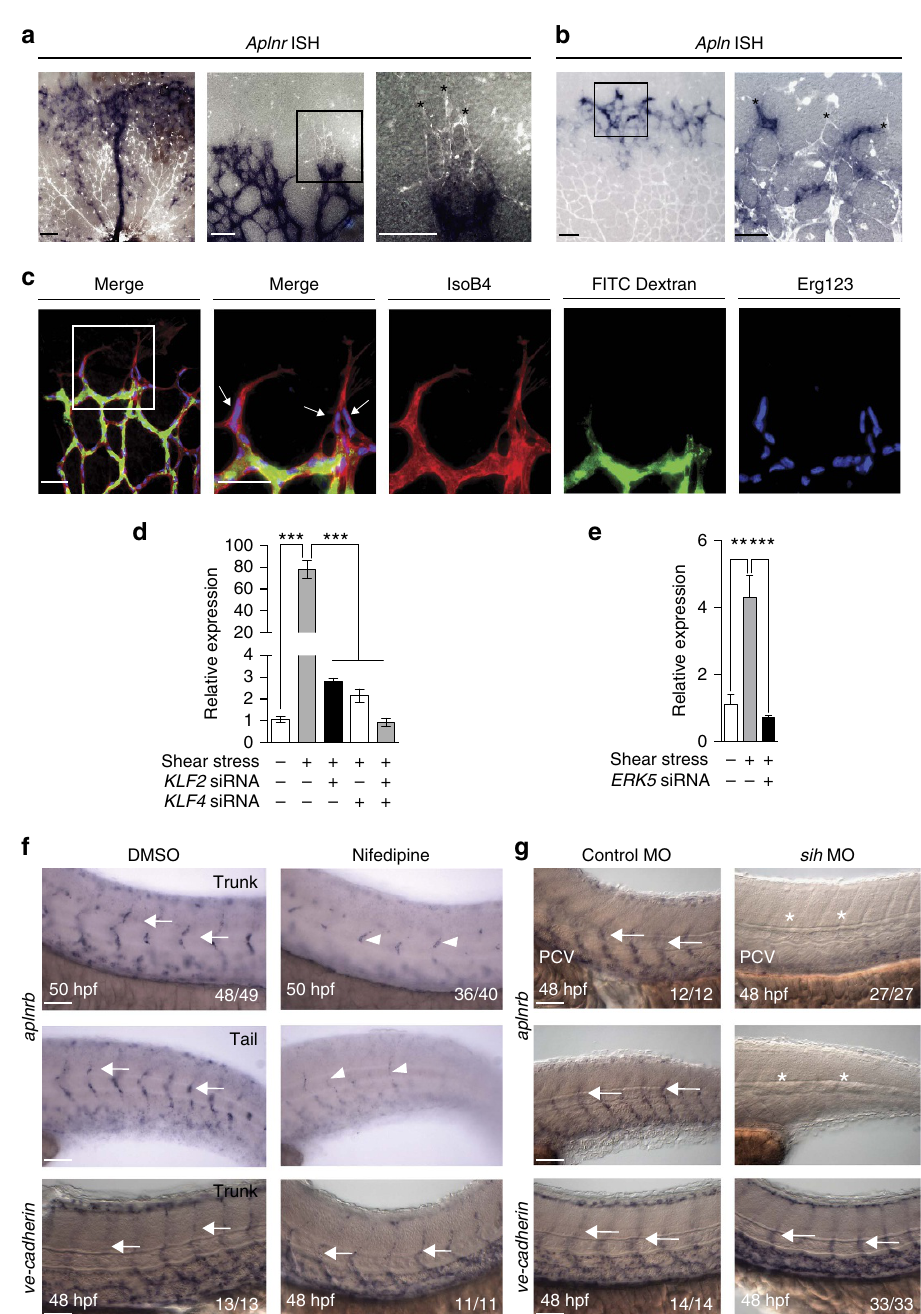
Figure 2 | APLNR is expressed in newly lumenized vessels and its expression is flow-dependent. ( a ) Aplnr expression as determined by in situ hybridization (blue) in P5 retinal vasculature with Isolectin B4 staining (white). The boxed area in the middle image is magnified on the right to show higher magnification of the adjacent panel. Scale bar, 50 m m. n ¼ 3 retinas. ( b ) Apln expression as determined by in situ hybridization (blue) in P5 retinal vasculature with Isolectin B4 staining (white). The boxed area is magnified on the right to show higher magnification of the adjacent panel. Scale bar, 100 m m (low magnification) or 50 m m (high magnification). n ¼ 4 retinas. Tip cells are marked by the asterisks. ( c ) Localization of FITC Dextran in the P5 retinal vasculature (green) with Isolectin B4 (red) and Erg123 (endothelial nuclei) staining (blue). The higher magnification images are shown in the right panels. Scale bar, 50 m m. n ¼ 4 retinas. ( d ) APLNR transcript expression in response to shear stress alone or with concurrent KLF2 , KLF4 or combined knockdown via siRNA. ( e ) APLNR transcript expression in response to shear stress alone or with concurrent ERK5 knockdown via siRNA. ( f ) Aplnrb expression in the trunk and tail of zebrafish embryos at 50 hpf with or without nifedipine (2h treatment). Arrows (DMSO) and arrowheads (nifedipine) demarcate aplnrb expression. ( g ) Aplnrb expression in the trunk and tail of zebrafish embryos at 48hpf with sih or control morpholino (MO) injection. Asterisks mark absence of aplnrb staining in intersegmental vessels (ISVs). Staining in the posterior cardinal vein (PCV) is also reduced. In situ hybridization with the pan-endothelial marker vascular endothelial cadherin (ve-cadherin) shows normal vascular morphology in all conditions. Arrows mark intersegmental blood vessels. Scale bar, 50 m m. ** P r 0.01, *** P r 0.001, t- test. Error bars represent